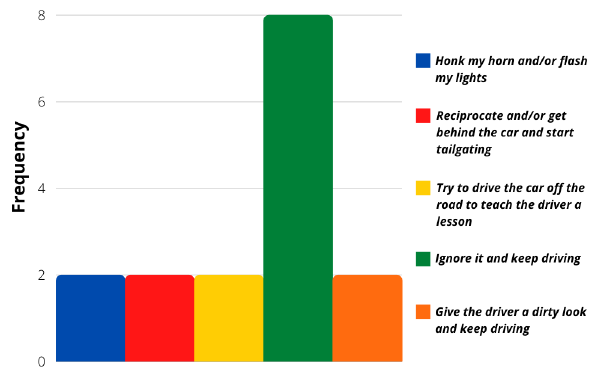
Figure 8. Question 54 results.